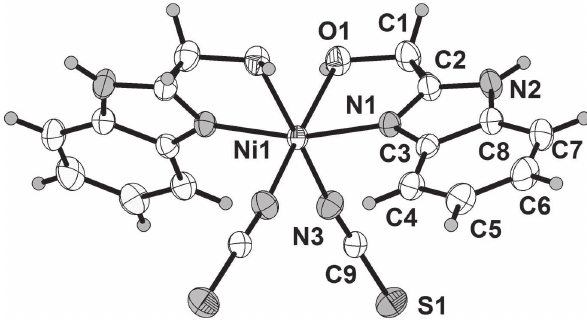
Table 1: Data collection and handling.